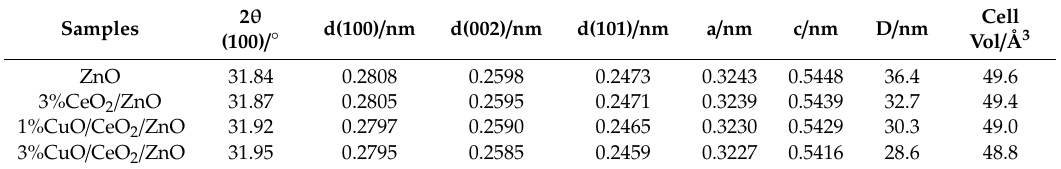
Figure 1. ( a ) X-ray Di ff raction (XRD) patterns of the as-synthesized samples. ( b , c ) Scanning Electron Microscope (SEM) images of sample 3%CuO / CeO 2 / ZnO; ( d – f ) Transmission Electron Microscope (TEM) images of sample 3%CuO / CeO 2 / ZnO. Table 2. Microstructural parameters and crystallite size of as-synthesized samples ( θ , d, a, c, and D represent the di ff raction angle, interplanar spacing, lattice parameters a and c, and the diameters of ZnO,